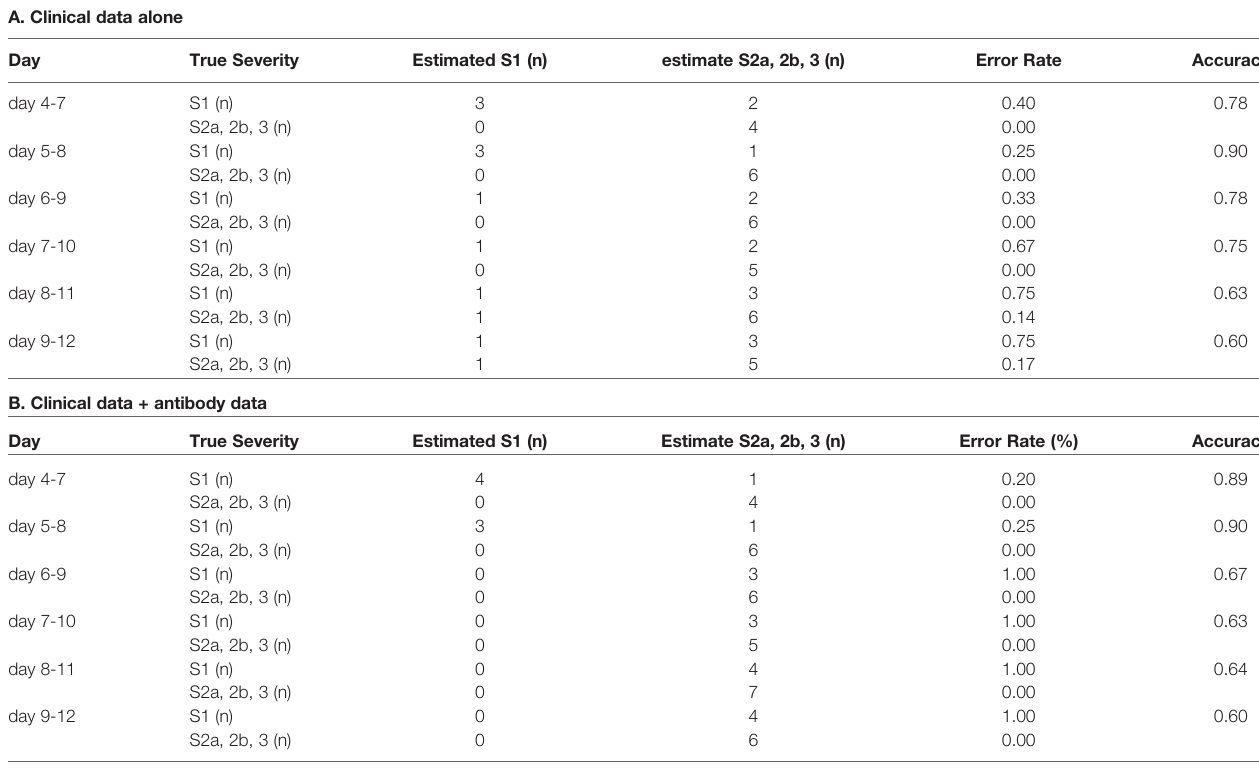
TABLE 3 | The accuracy of the model to distinguish severity group 2a or over from severity group 1 in the cases of breakthrough infection.